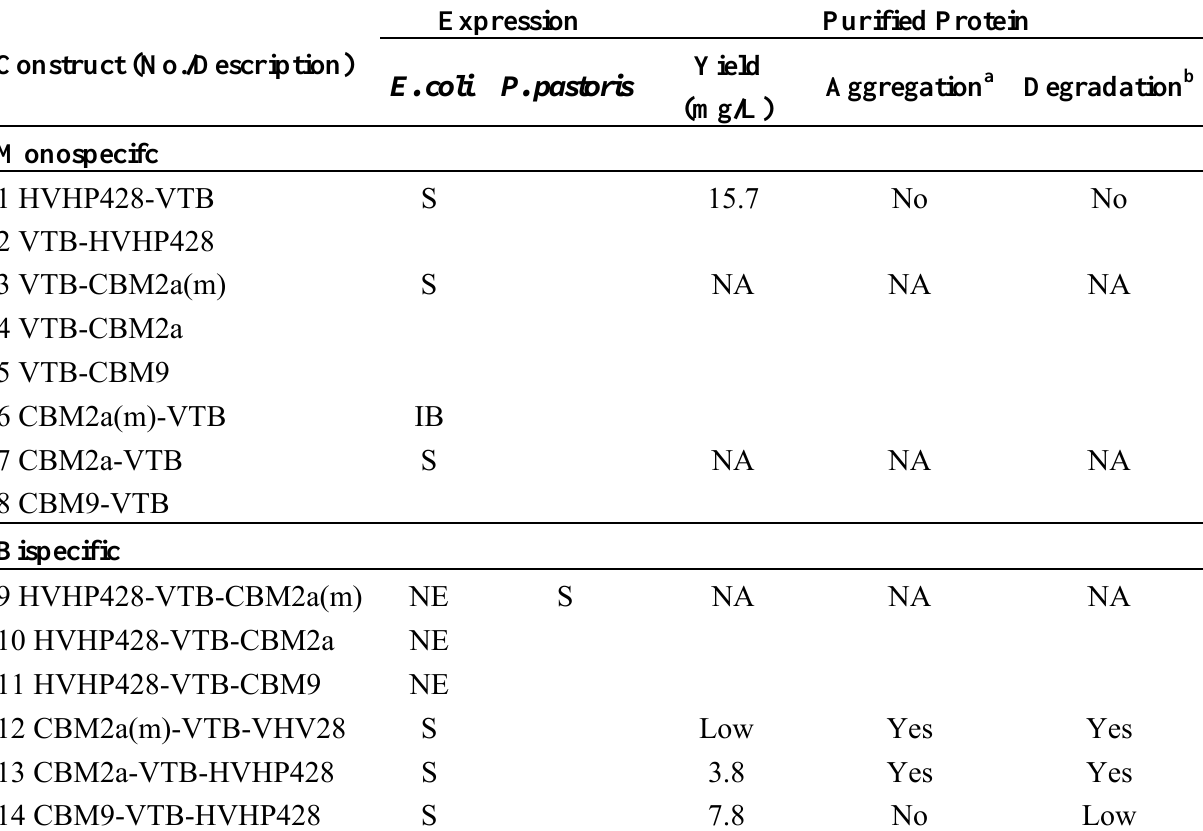
Table 2. Summary of constructs, expression profiles, and purified proteins.